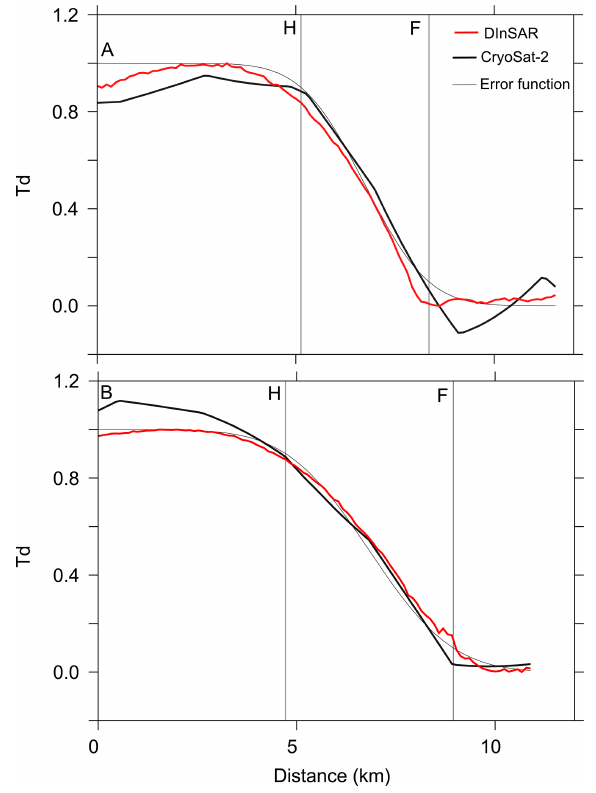
Figure 4. Cross sections of T d (solid black line) with the fitted error function (dashed black line) and the normalised deformation mea- sured from Sentinel-1 double-differenced interferograms (red line), for two cross sections across the Carlson Inlet (a) and Evans Ice Stream (b) as shown in Fig.